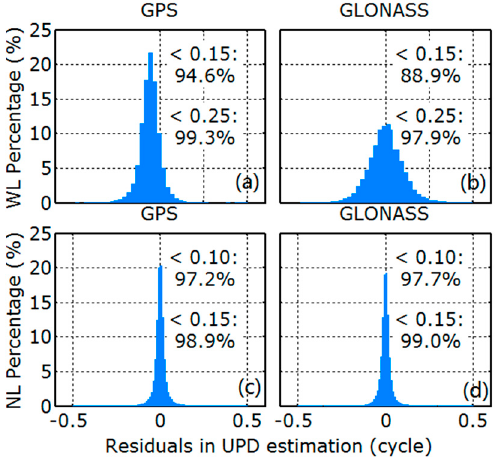
Figure 11. Distribution of a posteriori residuals of WL ( a , b ) and NL ( c , d ) float ambiguities for GPS and GLONASS (( a , c ) to ( b , d )) in UPD estimation using reference stations.